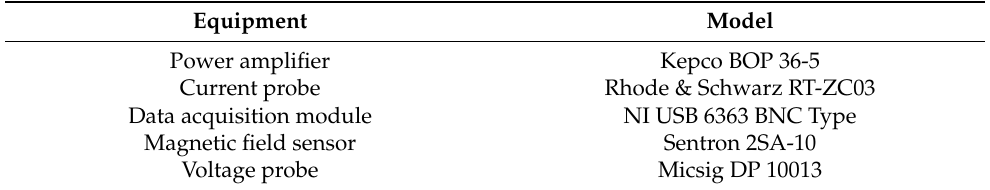
Table 2. Instrumentation adopted in the SDT testing frame: apparatuses and corresponding